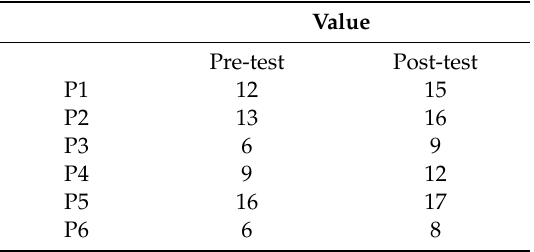
Table 12. Grouped results pre-test / post-test of the self-control